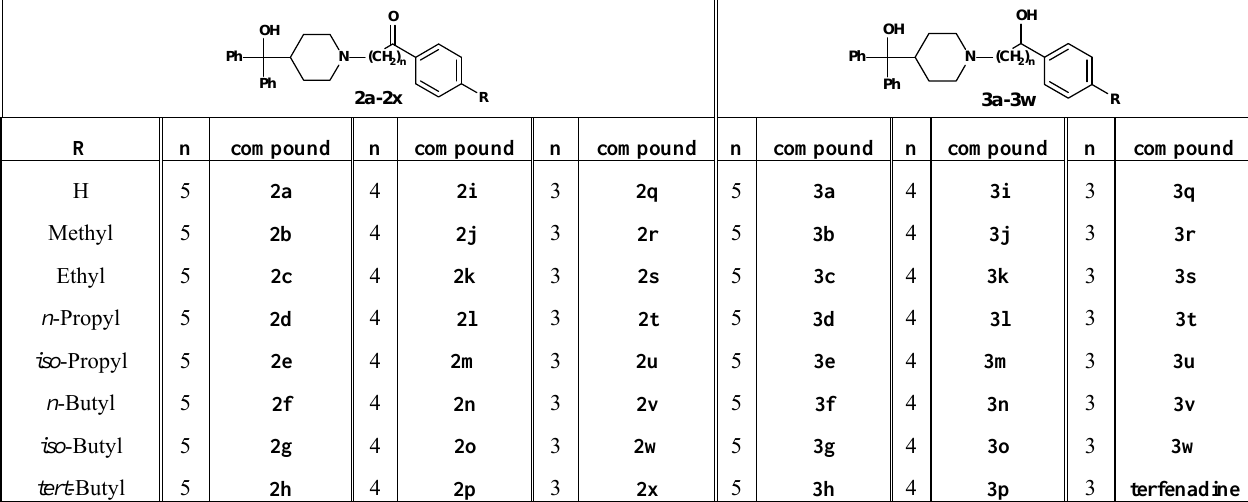
Table 2. Synthesized terfenadine derivatives 2a-2x and 3a-3w (n = 3-5; R = H; C